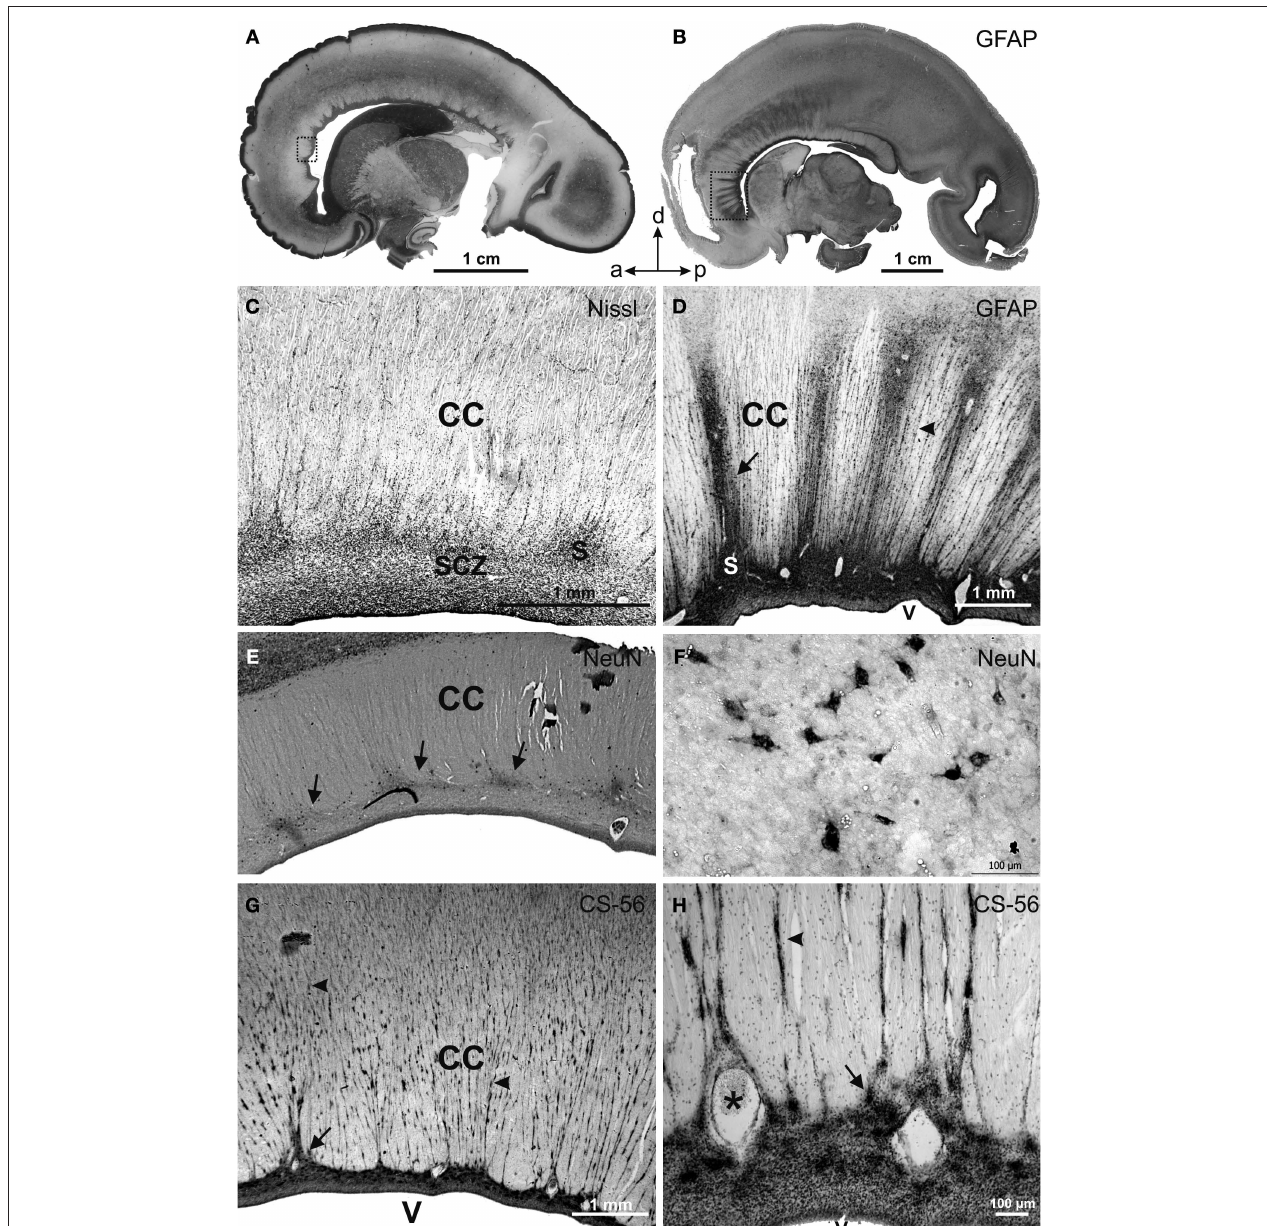
FIGURE 2 | Parasagittal (A) and midsagittal (B) sections of the human fetal brain showing the transient cellular structures callosal septa at 21 (A), 24 (E–H) and 25 (B–D) PCW stained with Nissl (A,C), glial fi brillary acidic protein (GFAP) (B,D), neuronal-specifi c nuclear protein (NeuN) (E,F) and chondroitin sulfate proteoglycan (CS-56) (G,H) immunocytochemistry. Framed areas in (A) and (B) are enlarged